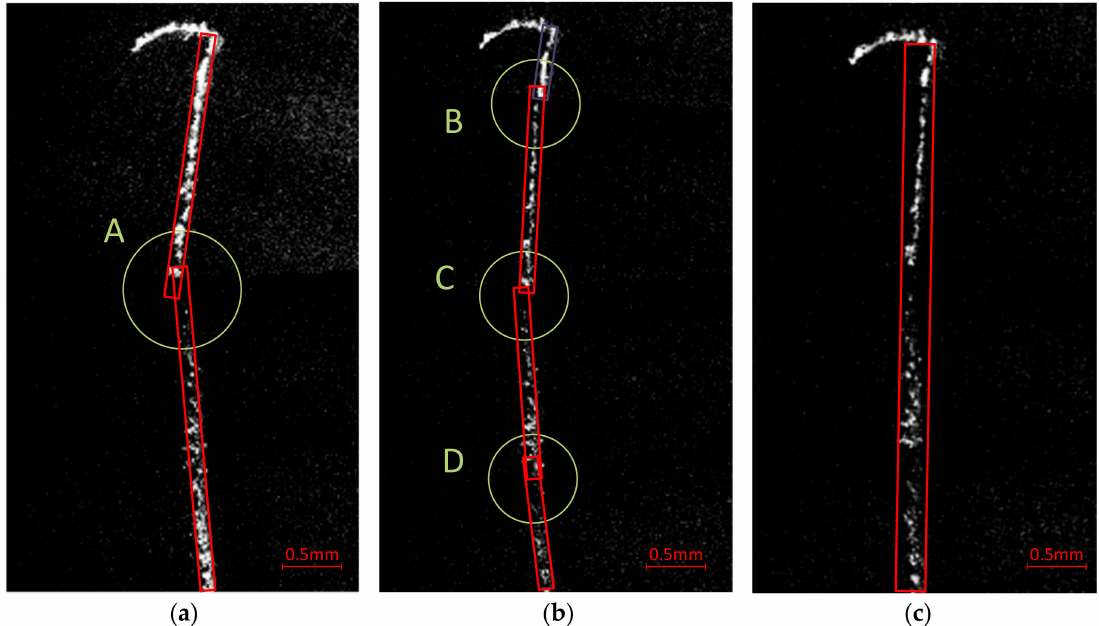
Figure 18. Improvement of scratch mismatch correction with and without our proposed method. ( a ) Stitching result with conventional stitching strategy (two sub-apertures with small overlapping area); ( b ) Initial stitching result with four consecutive sub-apertures, in accordance with our scanning and stitching strategy; ( c ) Stitching result after the scanning path correction